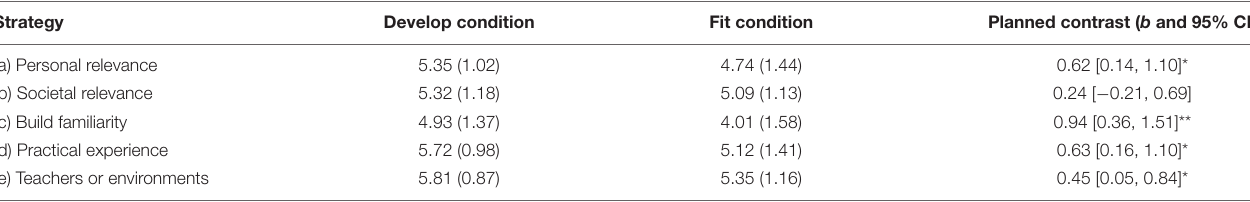
TABLE 3 | Study 2 group means (Standard Deviations) and regression contrasts comparing participants’ cultivation strategy-use intentions between the Develop and Fit conditions. Strategy Develop